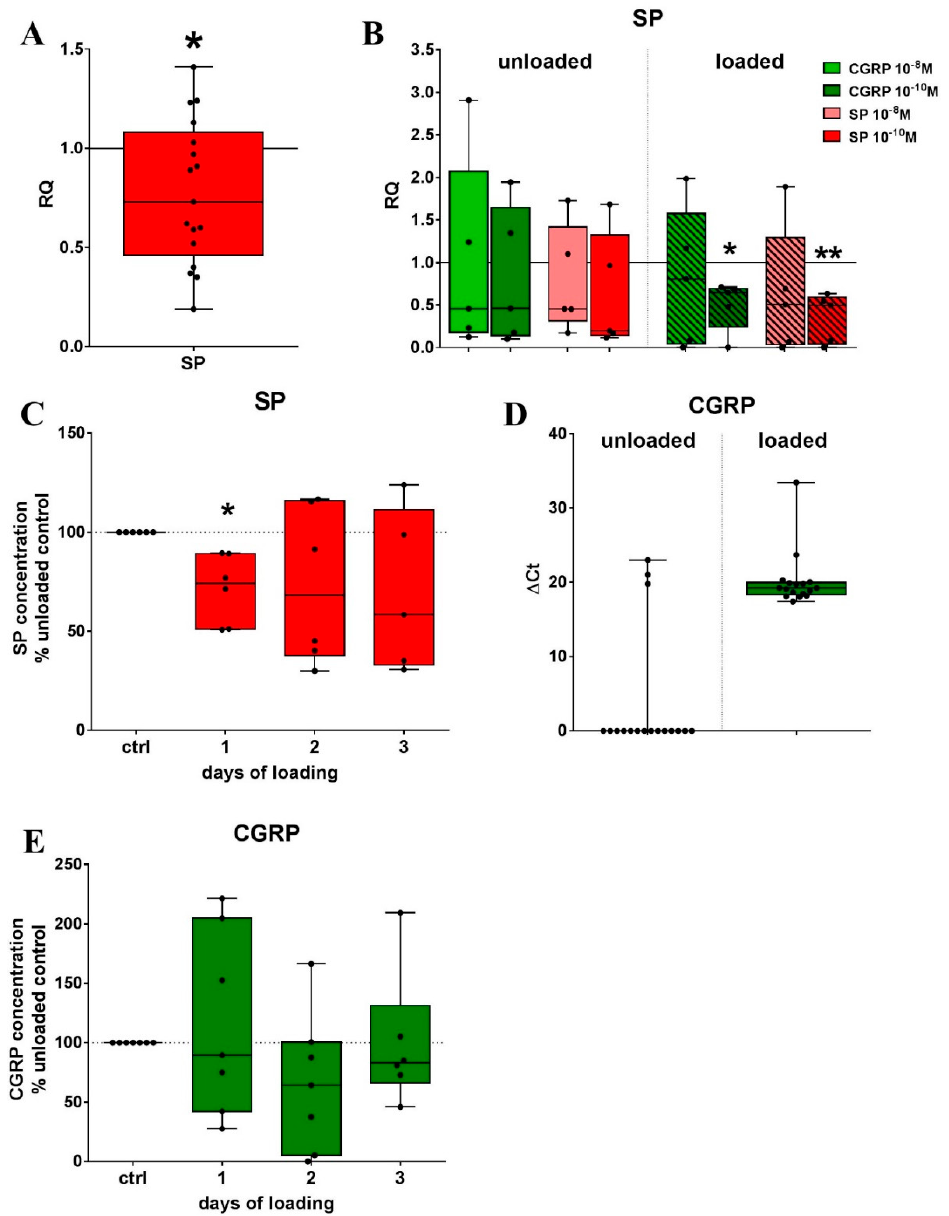
Figure 3. The influence of mechanical loading on gene and protein expression of the sensory neuropeptides SP and α CGRP in RAW264.7 cells. ( A , B ) Relative gene expression of SP ( A ) and alterations of SP expression by stimulation with SP and α CGRP ( B ) after 4-h loading per day on two consecutive days in relation to unloaded cells (calibrator, RQ = 1) was analyzed using quantitative real-time PCR; ( D ) α CGRP gene expression is depicted as ∆ C t of unloaded and loaded cells after 4 h/day stretching on 2 consecutive days. Normalizer: GAPDH . One sample t -test * p < 0.05, ** p < 0.01. SP, α CGRP expression n = 20, SP expression after stimulation with SP/ α CGRP n = 5; ( C , E ) Protein concentration of SP ( C ) and α CGRP ( E ) was determined in the cell culture supernatants after 4 h/day loading on 1, 2 or 3 days using ELISA. One sample t -test * p < 0.05. n = 7–8. SP—substance